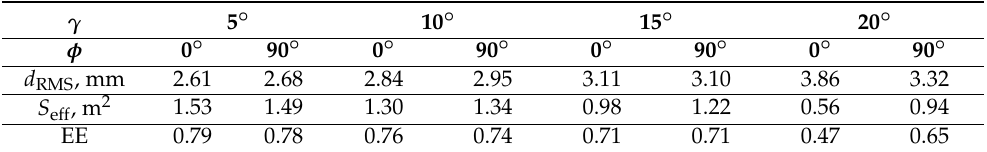
Figure 3. Spot diagrams of the NSRT model for γ = 5 ◦ ,10 ◦ ,15 ◦ ,20 ◦ . Grid cell has a size of 1 mm × 1 mm. Table 2. K-EUSO optics performance: image size d RMS , effective area S eff and ensquared energy EE as a function of field angles γ , φ